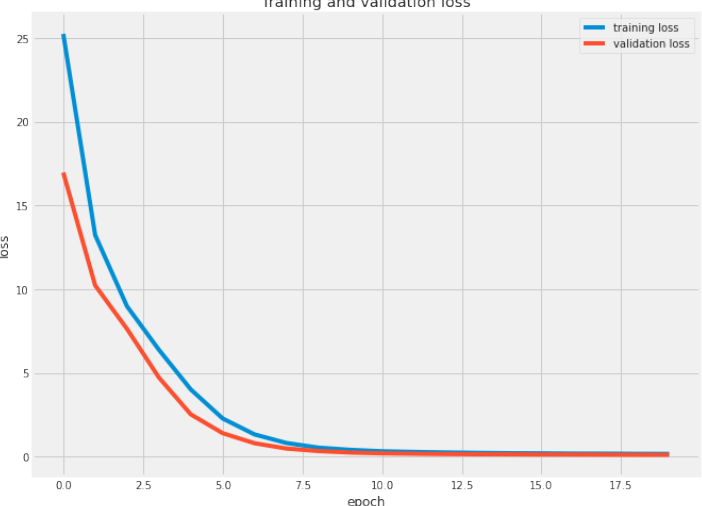
Figure 8. Training and validation loss.